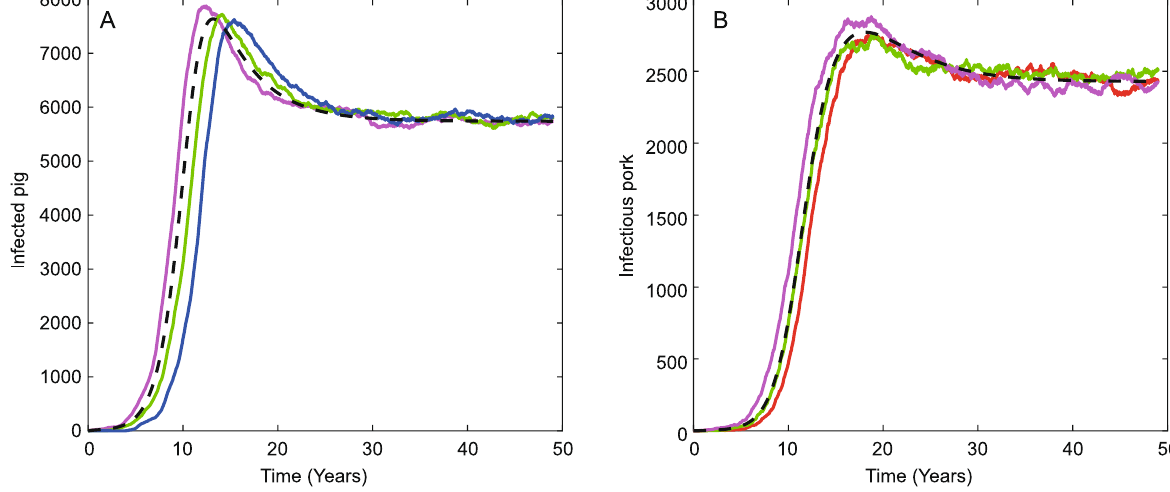
Fig. 6 Variation of infected pig and infectious pork over time. A . Infected pig; B . Infectious pork